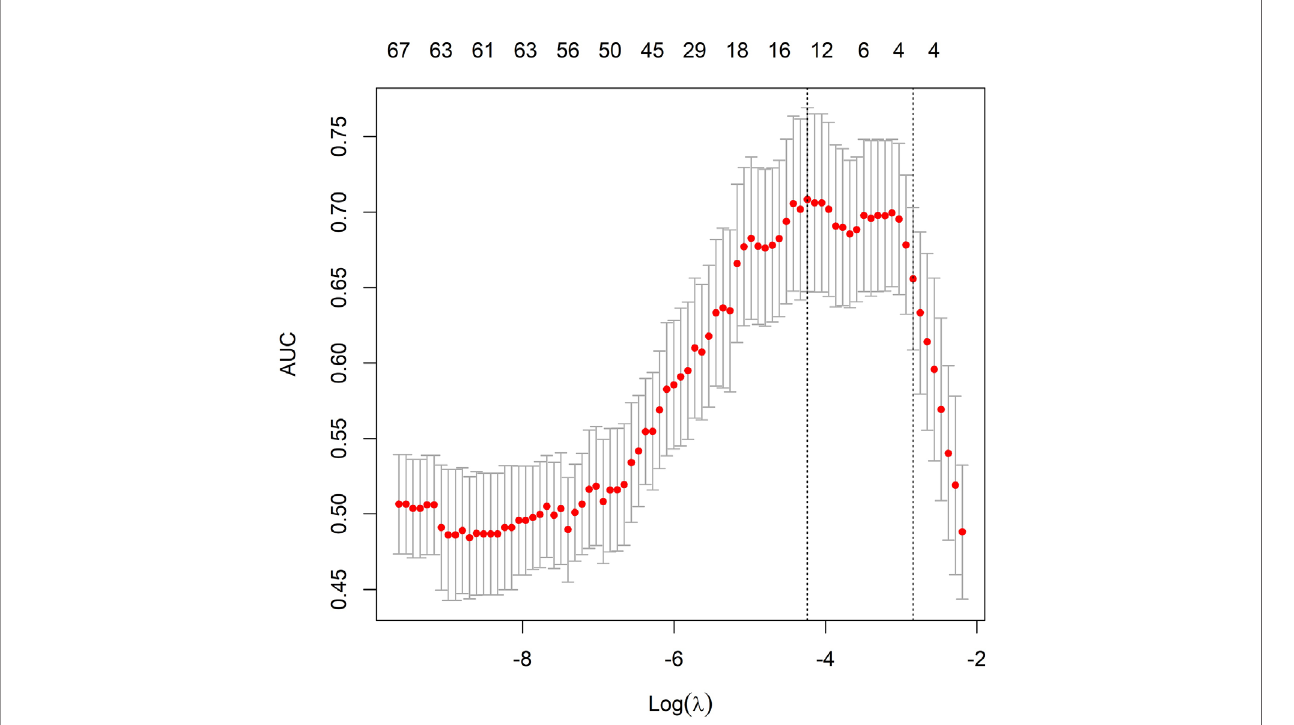
FIGURE 2 | Radiomic feature selection using the least absolute shrinkage and selection operator (LASSO) model. The area under the receiver operating characteristic (ROC) curve was plotted versus the logarithm of tuning parameter l . Dotted vertical lines were drawn at the optimal values using the minimum criteria and the 1 standard error of the minimum criteria (the 1-SE